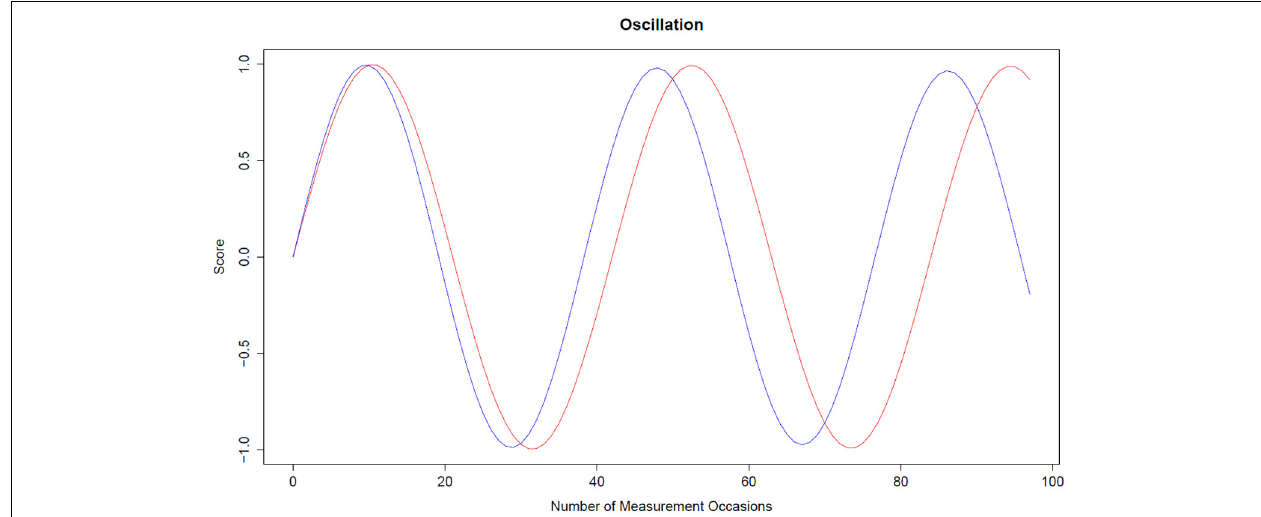
FIGURE 4 | Oscillation curve. The red line represents an oscillation for D = 11 and K = 10 with η = − 0 . 0224, ζ = − 0 . 0002, and λ = 40. The blue line represents an oscillation for D = 7 and K = 10 with η = − 0 . 0269, ζ = − 0 . 0008, and λ = 38 . 3.